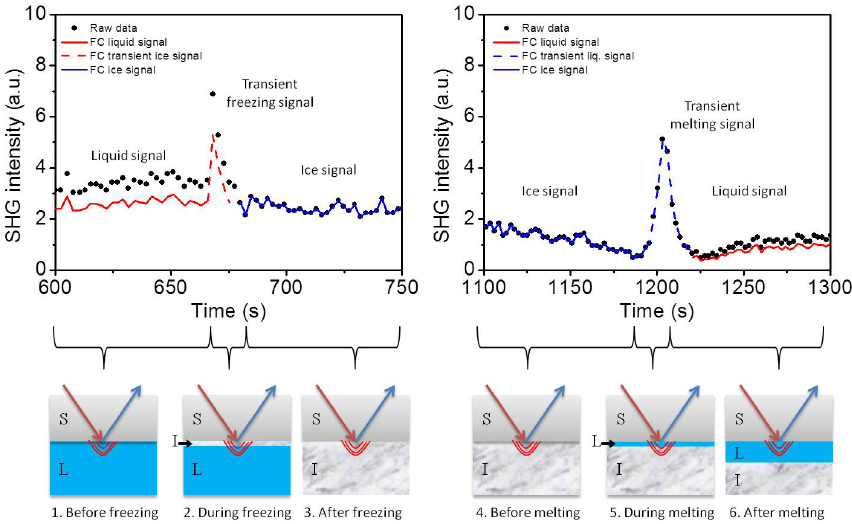
Figure 7. Upper panels: a comparison between SHG signal, corrected (continuous and dashed lines) and non-corrected (black solid circles) to the Fresnel factors, around the transient freezing peak (left panel) and around the transient melting peak (right panel) for TP cycle number 25. Red lines correspond to liquid phase, blue lines correspond to ice phase, and dashed lines correspond to transient signal. Lower panels: a schematic representation of the development of the ice forming and melting at the interface around freezing and melting events, respectively. FC refers to Fresnel corrected